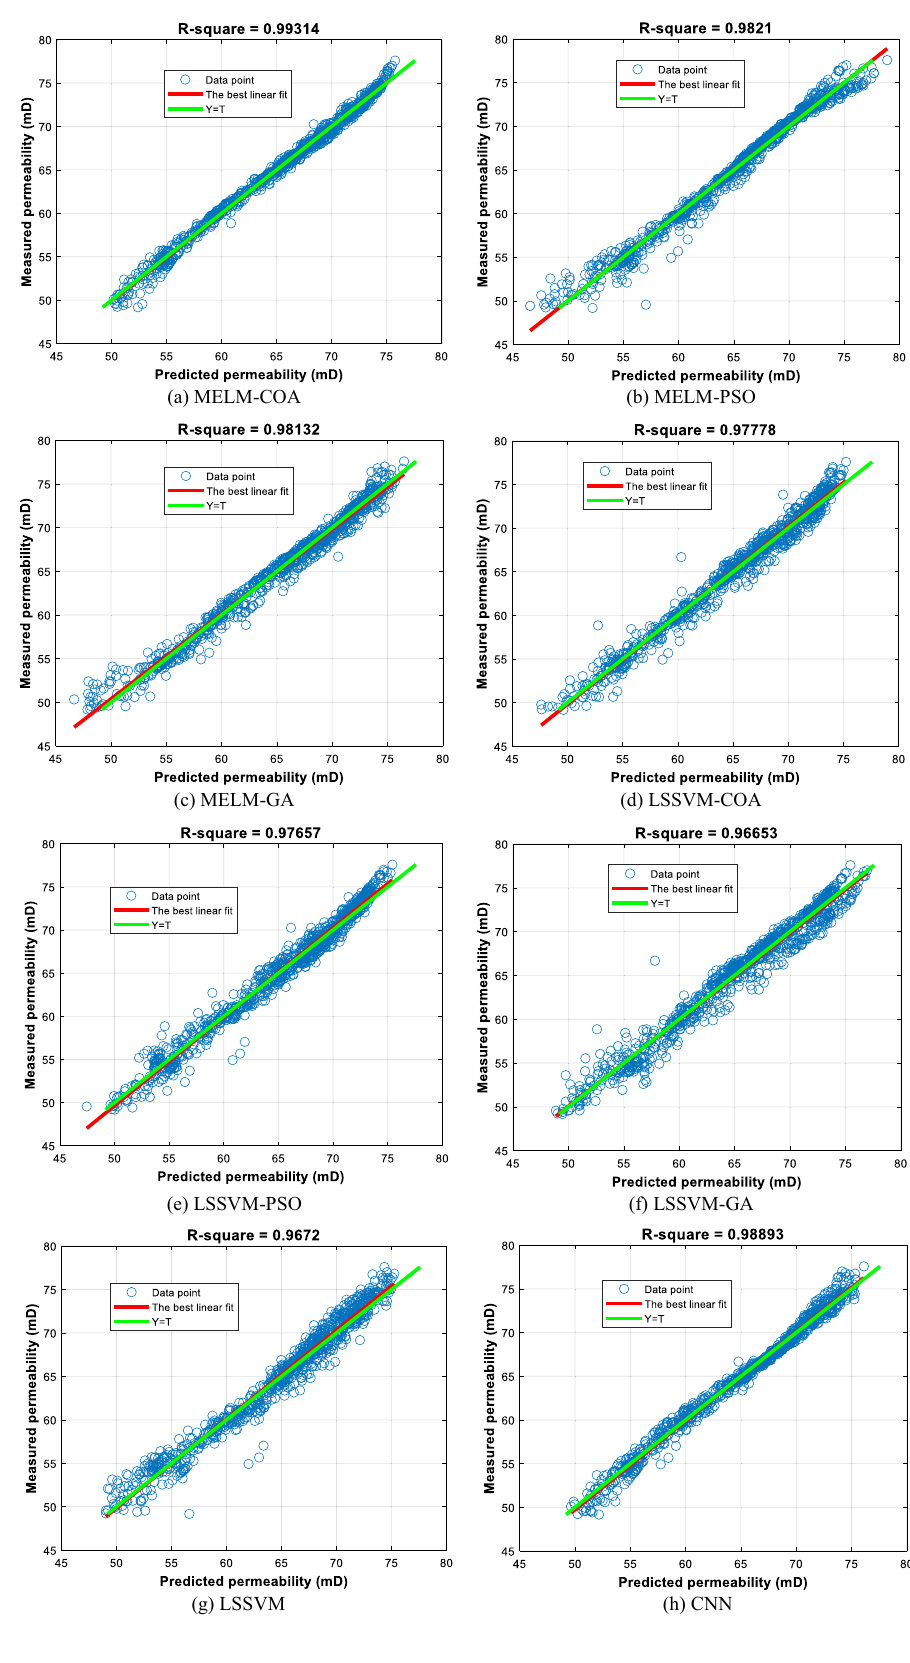
Fig. 10 Cross plots of measured and predicted permeabilities based on the training data using the hybrid and simple CNN and LSSVM. a MELM-COA